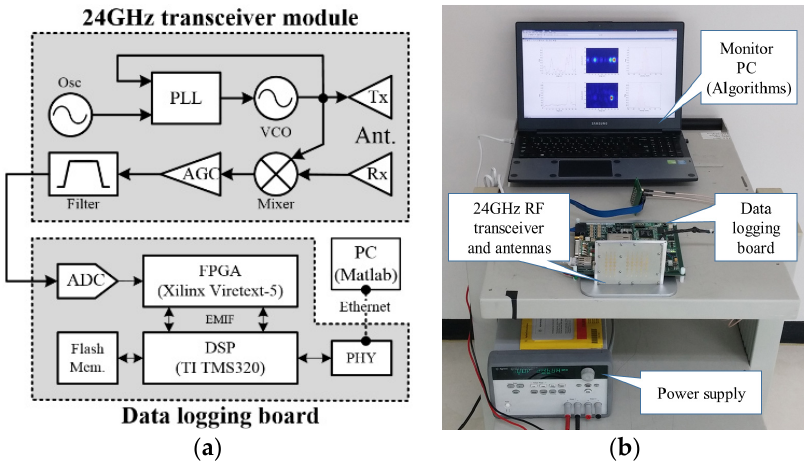
Figure 6. Measurement set-up using real time logging system together with 24 GHz FMCW transceiver: ( a ) block diagram of the developed radar test bed; and ( b ) photo of measurement set-up.